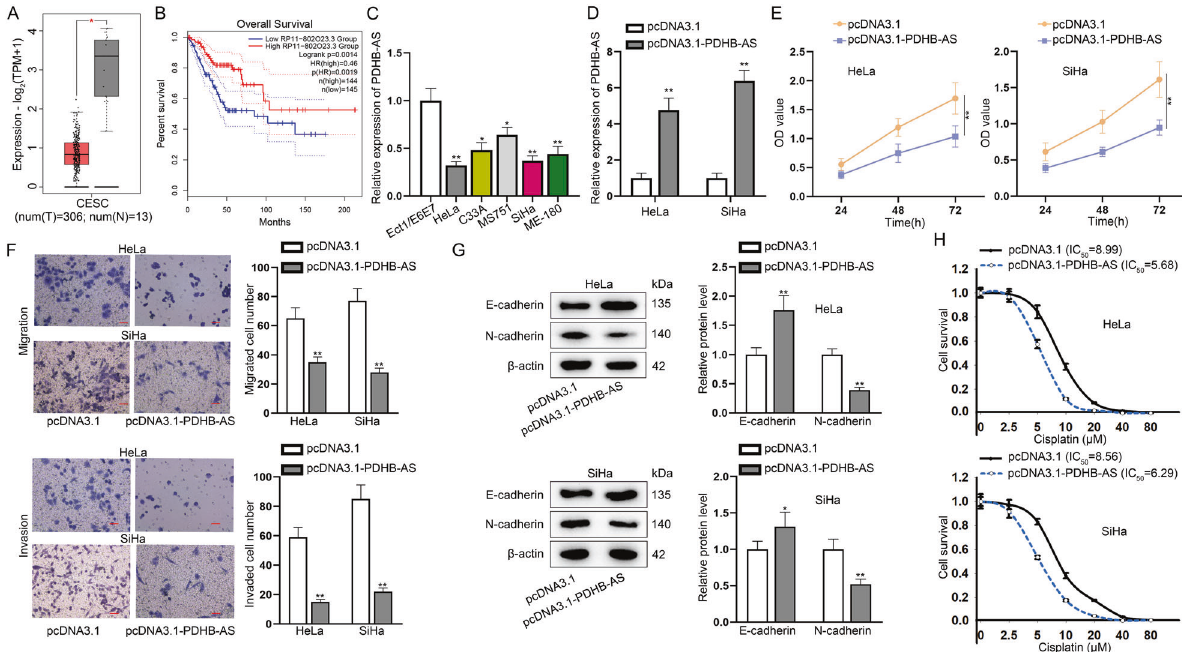
Fig. 1 PDHB-AS is down-regulated in CC cells. A GEPIA predicted the expression of PDHB-AS in CESC and normal tissues. B The association between PDHB-AS expression and overall survival of CESC patients was predicted on GEPIA. C PDHB-AS expression levels were examined via RT-qPCR in CC cells (HeLa, C33A, MS751, SiHa and ME-180) versus the normal cell (Ect1/E6E7). D PDHB-AS overexpression ef fi ciency was analyzed via RT-qPCR. E CCK-8 assay evaluated the proliferation of HeLa and SiHa cells under PDHB-AS overexpression. F Transwell assay tested the invasion and migration ability of HeLa and SiHa cells with PDHB-AS overexpression. G The protein levels of E-cadherin and N-cadherin in HeLa and SiHa cells were measured by western blot with PDHB-AS overexpression. β -actin was the loading control. H The effect of PDHB-AS overexpression on IC 50 values to cisplatin of HeLa and SiHa cells was measured via CCK-8 assay. * P < 0.05, ** P <